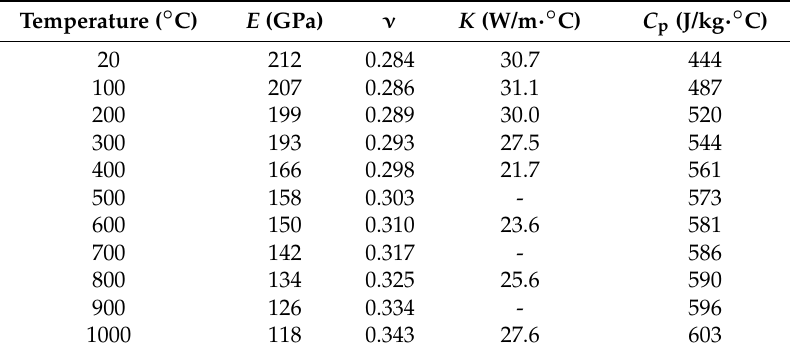
Table 4. Thermomechanical properties for boron steel [18].